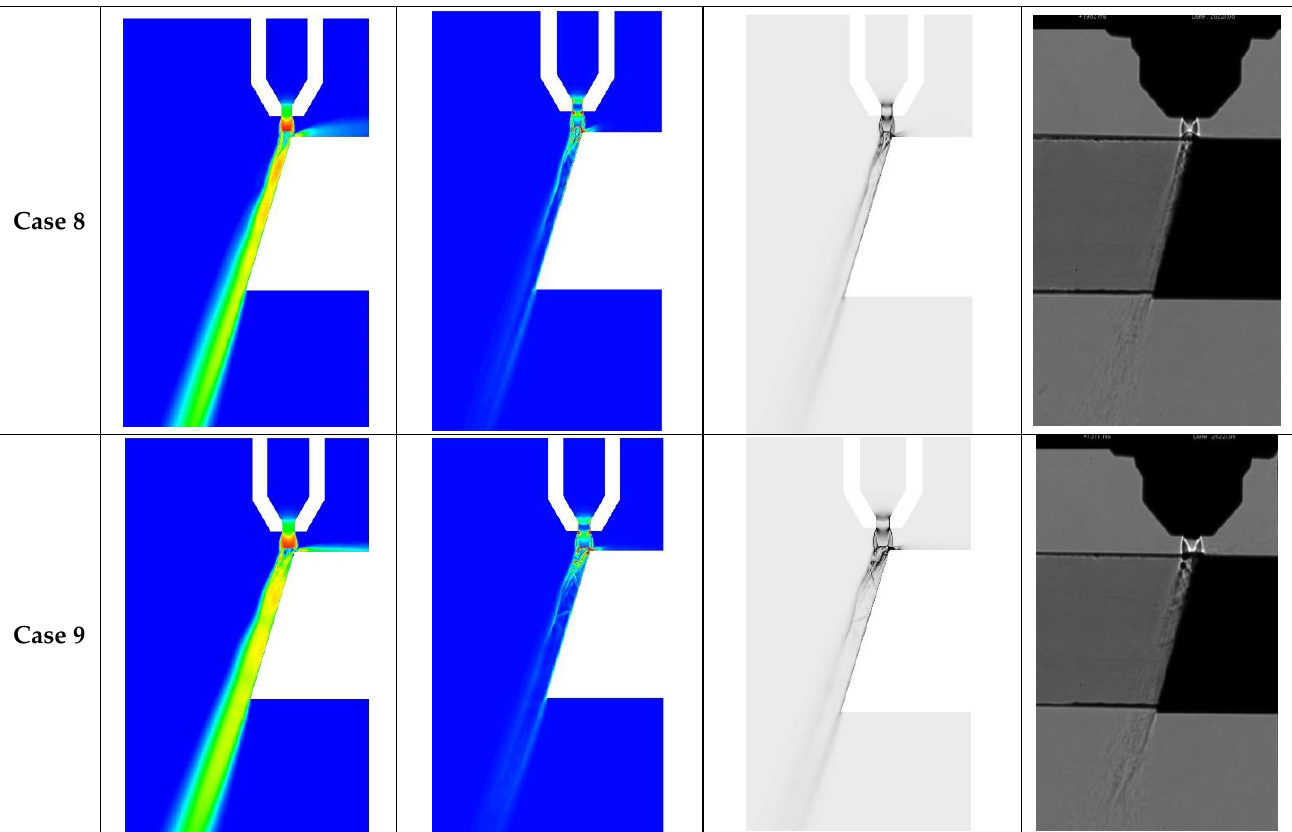
Figure 20. Flow behavior comparison between simulation results and experimental results.